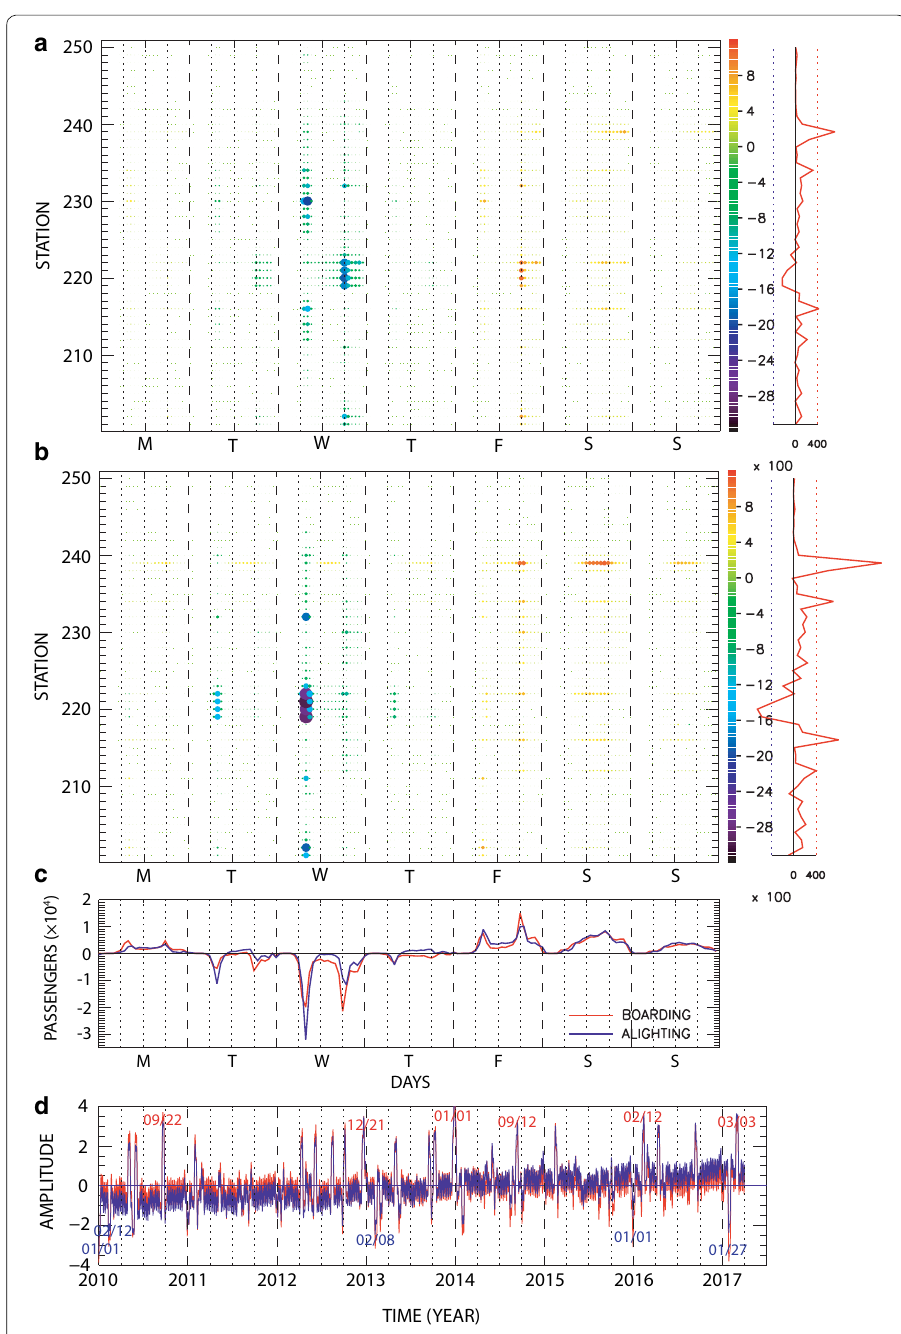
Fig. 8 The third mode of CSEOF representing the weekly patterns of passengers for Subway Line #2: a hourly and total number of boarding passengers at each of the 50 subway stations numbered from 201 to 250; b hourly and total number of alighting passengers; c number of boarding (red) and alighting passengers in all stations; and d corresponding amplitude time series. Heightened activities are noted on Wednesdays complementing the second CSEOF